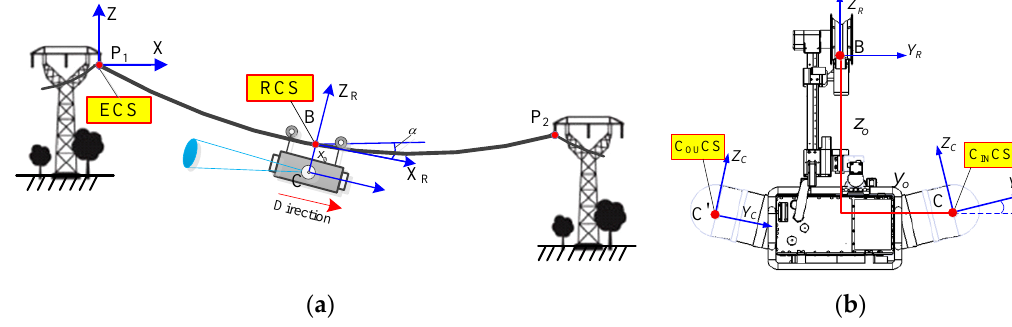
Figure 10. Coordinate systems of the autonomous inspection: ( a ) ECS and RCS; ( b ) C IN CS and C OU CS. ECS is the reference point coordinate system; RCS is the CIR body coordinate system, and the origin of RCS is defined as the mid-point of the two pressure wheels. C IN CS and C OU CS are two PTZ coordinate systems, i.e., inward view and exterior view, respectively, which have the specified geometric centers of the cameras as their origins. α is the angle between the robot on the ground wire and the horizontal plane. β is the installation angle between the PTZ camera and the horizontal plane. ECS is a fixed-coordinate system; RCS and CCS are mobile-coordinate